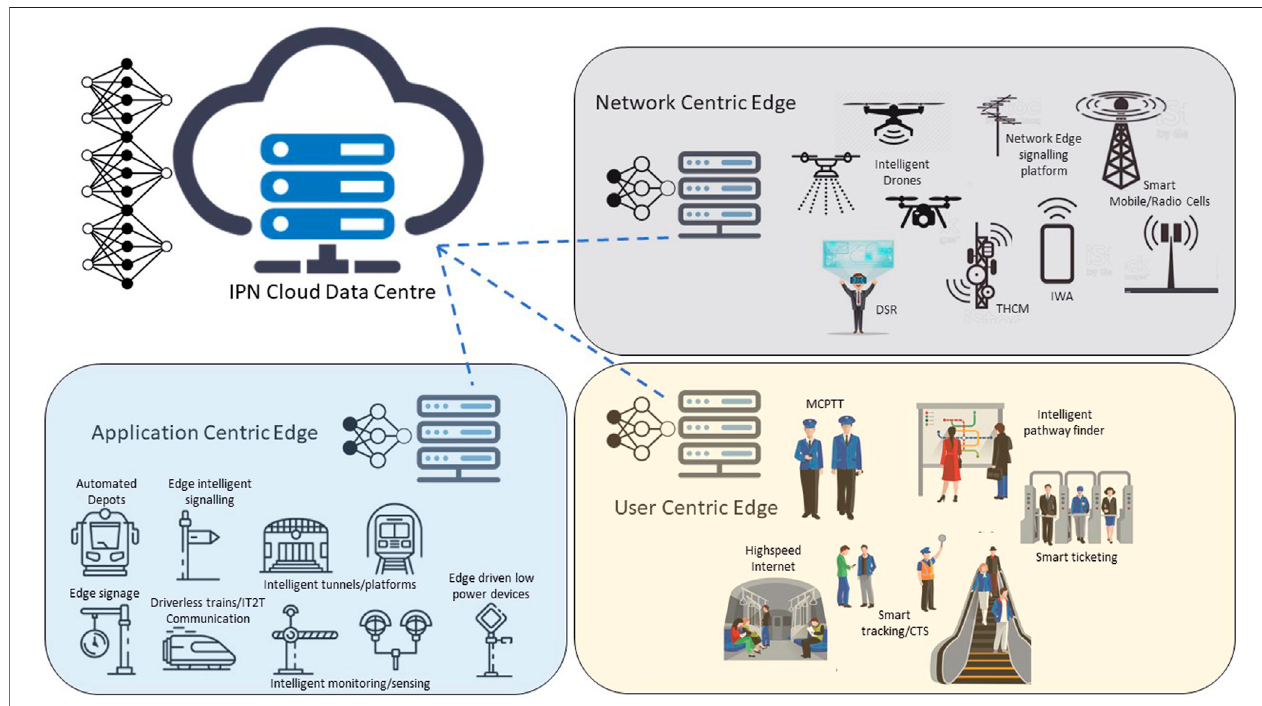
FIGURE 2 | IPN-driven edge intelligent NGRS